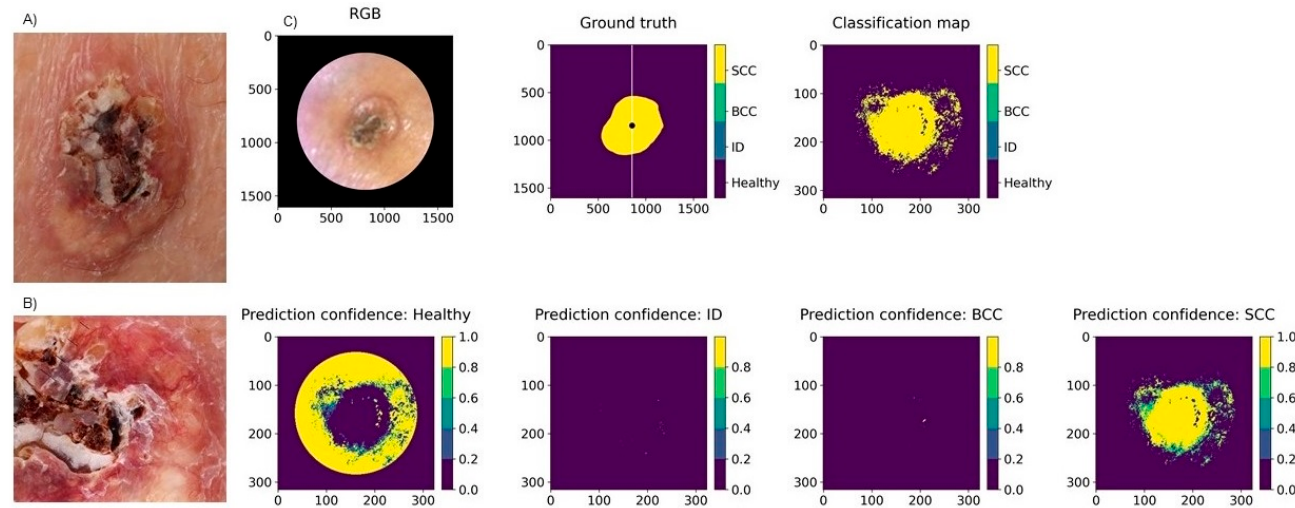
Figure 9. Clinical ( A ) and dermoscopy image ( B ) and the classification map ( C ) of a 15 mm SCC on the leg. Clinically, this lesion could be either a BCC or a SCC, but it was correctly classified as a SCC by the system. The SICSURFIS system delineated the lesion accurately, although it was surrounded by some probable imaging artefacts caused by the uneven skin colour of the healthy skin.